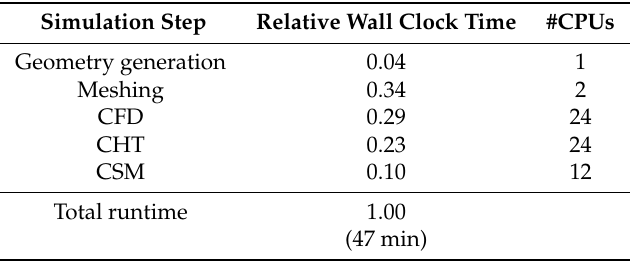
Table 4. Wall clock time within gradient-free